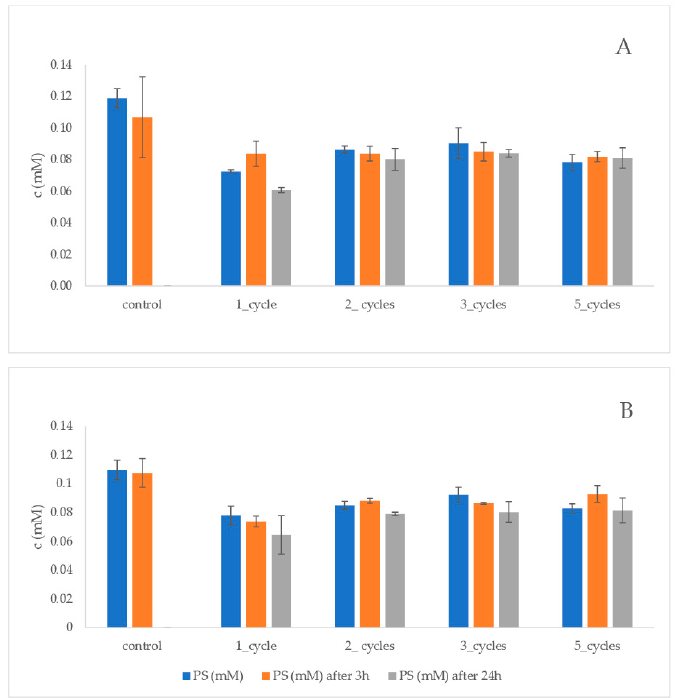
Figure 4. ( A ) Concentration of PS after treatment with PS (0.1 mM) activated by HC; 1, 2, 3, and 5 cycles through the unit corresponding with 4, 8, 12, and 20 s of treatment; ( B ) Concentration of PS after treatment with PS (0.1 mM) activated by HC combined with heat (60 ◦ C); 1, 2, 3, and 5 cycles through the unit corresponding with 4, 8, 12, and 20 s of